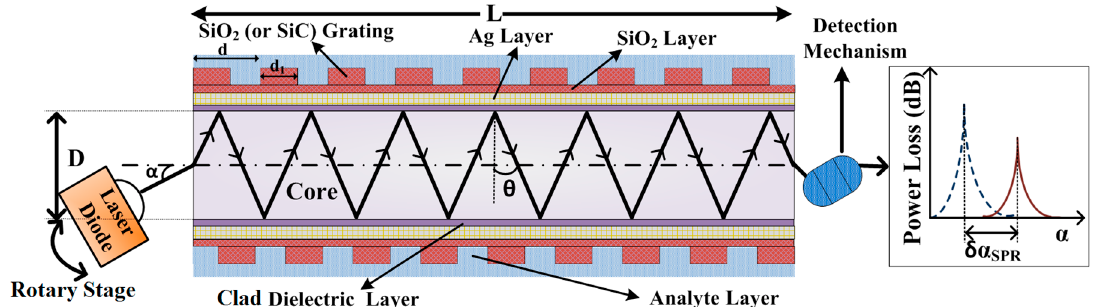
Figure 1. Schematic representation of grating based fiber optic sensor. D is the fiber core diameter and L is the fiber (sensing region) length considered as 1 cm in the present work. d is the grating period and d 1 is the groove width. The dielectric layer is the perfluorinated (PF) homopolymer. Table 1. 830 nm wavelength.